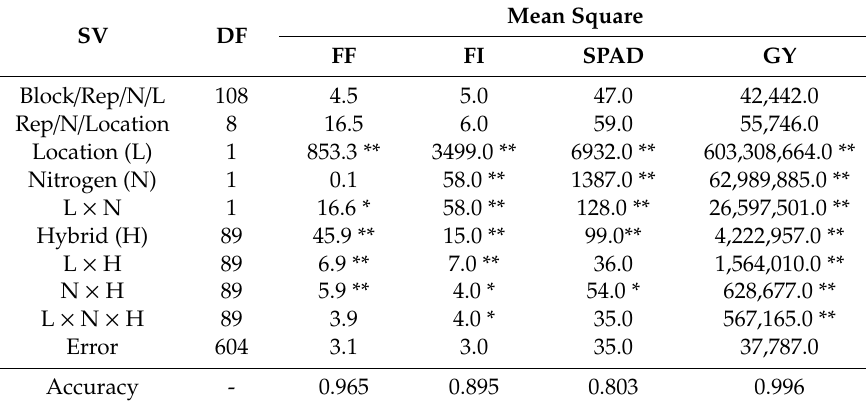
Table 3. Summary of the combined analysis of variance for the variables female flowering (FF) in days, male to female flowering interval (FI) in days, chlorophyll content (Soil Plant Analysis Development, SPAD), and grain yield (GY) in kg ha − 1 , of 90 popcorn genotypes evaluated under low and ideal nitrogen